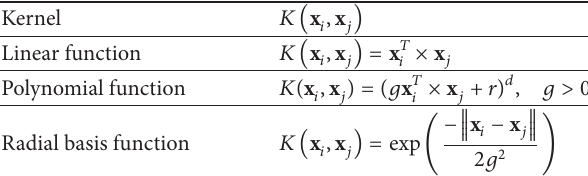
Table 2: Formulation of kernel functions.